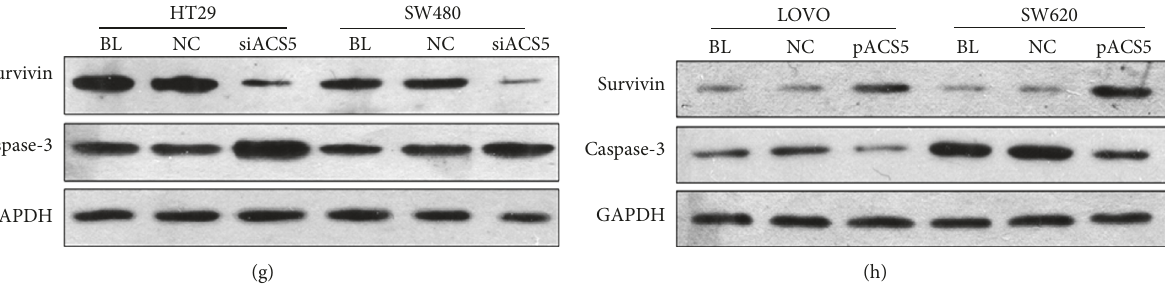
Figure 7: ACS5 affects CRC cells growth and metastasis through the modulation of survivin and CD44 expression. ((a), (b), (c), (e), (g)) The downregulation of ACS5 in HT29 and SW480 cells resulted in a significant reduction in survivin and CD44 expression and striking increase in caspase-3 and E-cadherin expression. ((a), (b), (d), (f), (h)) The expression of survivin and CD44 was significantly elevated, while the levels of caspase-3 and E-cadherin expression were markedly decreased in ACS5 overexpressed SW620 and LOVO cells. ∗∗ 𝑃 < 0.01 versus negative control or blank control group. BL, blank control; NC, negative control; siACS5, ACS5 siRNA; pACS5,